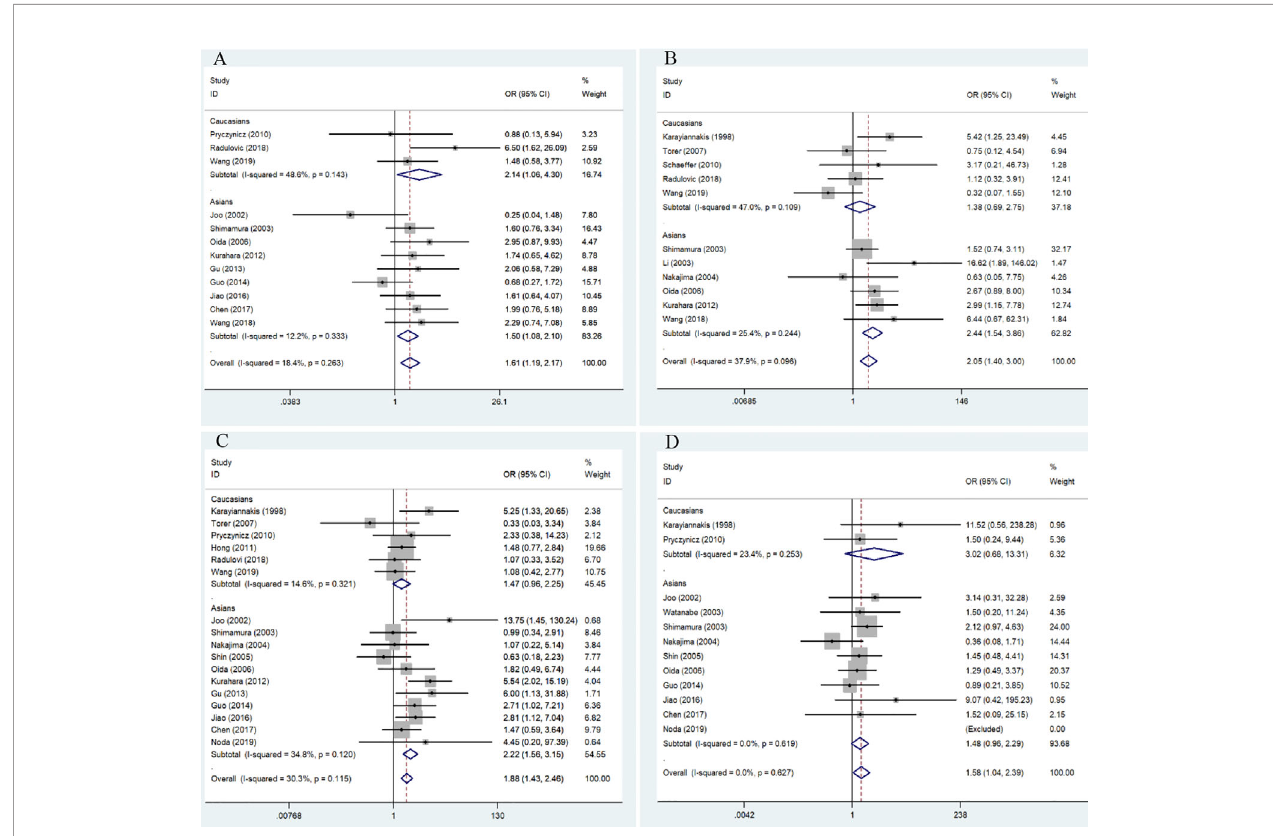
FIGURE 3 | Forest plot for the association of E-cadherin expression with gender, grade, lymph node metastasis, and differentiation of patients with pancreatic cancer. (A) gender; (B) tumor grade; (C) lymph node metastasis; (D)